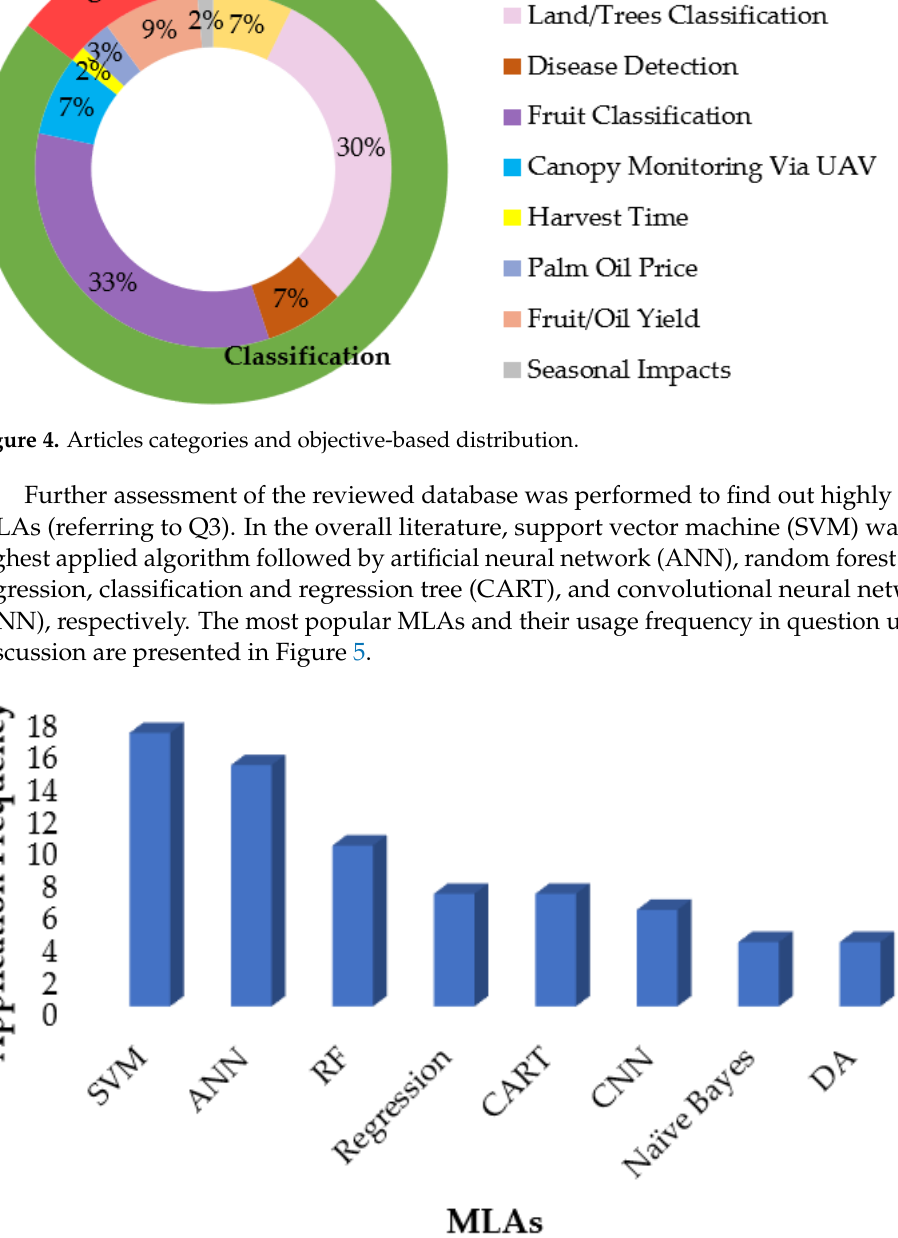
Figure 5. Highly adopted MLAs.